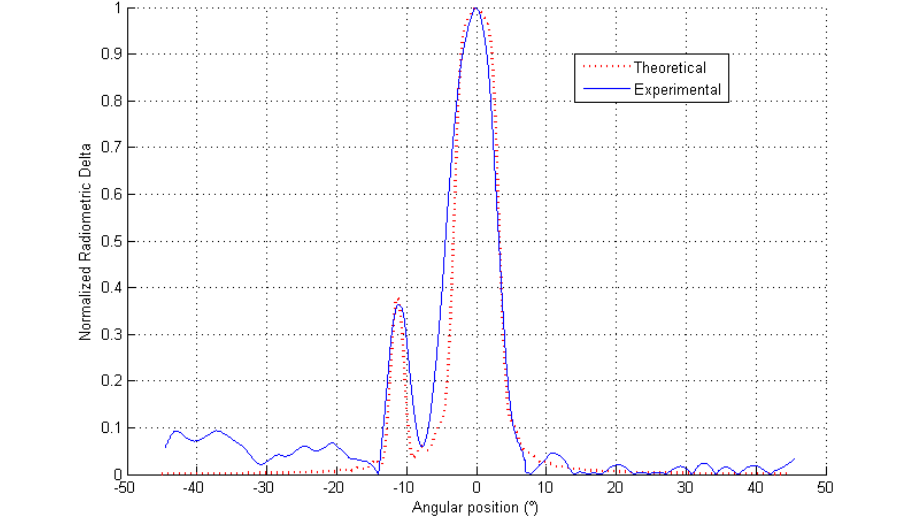
Figure 20. Radiometric pulses after search of two passive